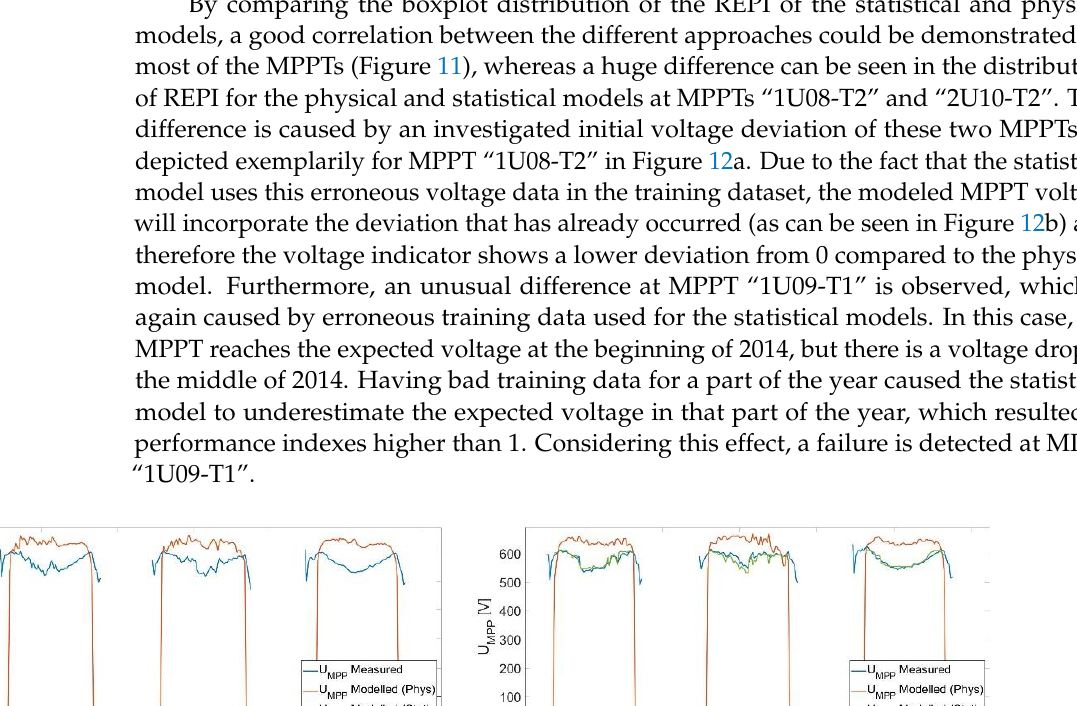
( b ) Figure 13. Boxplots of RVPI ( a ) and RCPI ( b ) for a selected subset of MPP trackers calculated using physical models and statistical models.